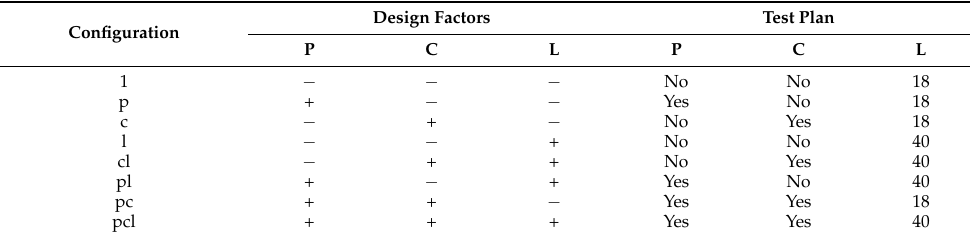
Table 6. Design factors and test plan. P corresponds to the application of a plasma treatment; C means post-curing was performed in the composites; L refers to the reinforcement length, in mm.